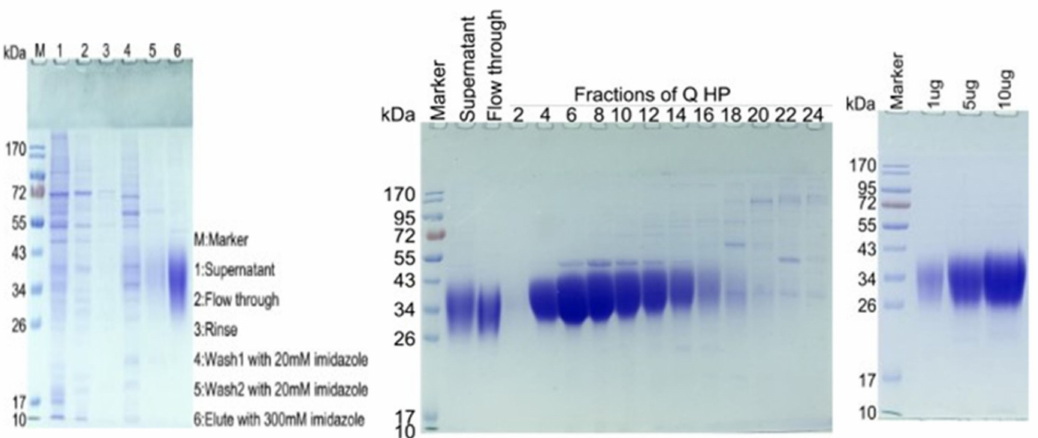
Figure 1. SDS-PAGE analysis of CD47-His after the Ni column showed a molecular weight of ~34 kDa ( left figure). Based on the result, fractions of flow through 4–14 were pooled together and concentrated by an ultrafiltration tube with a molecular cut-off value of 10 kDa ( middle figure). The SDS-PAGE analysis of final CD47-His showed a clean band with a molecular weight of ~34 kDa ( right figure). The theoretical molecular weight of CD47-His is 14.8 kDa. The SDS-PAGE re-sults show that the actual molecular weight is ~34 kDa due to the severe glycosylation modifica-tion of CD47.